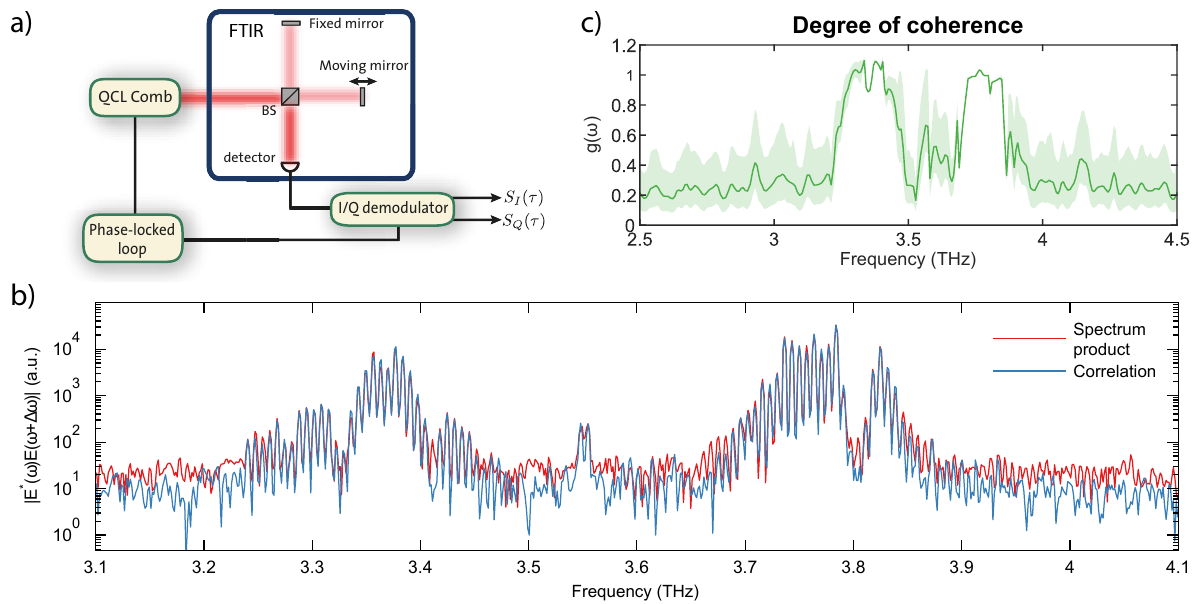
Figure 15: Shifted wave interference Fourier transform spectroscopy (SWIFTS). a Schematic representation of SWIFTS characterization sys- tem. The output of a FTIR is sent to a high-bandwidth detector. The detected signal is sent to an I/Q demodulator in order to get access to the in-phase and quadrature signals, S I ( τ , ω 0 ) and S Q ( τ , ω 0 ) ,respectively. By combining both signals, the correlation of the electric field of two adjacent modes < E * ( ω ) E ( ω ± ν rep ) > can be calculated. The intermode beatnote of the QCL has to be phase-locked to the local oscil- lator of the I/Q modulator. b SWIFTS correlation spectrum together with the spectrum product. Similar to the intermode beat spectroscopy, these results analyzed with SWIFTS also shows that most of the spectral power is in the frequency comb. c Degree of relative coherence g ± ( ω , ω ± ν rep ) obtained by SWIFTS. Results published in [70, 75]. Table 1: Comparison between intermode beat spectroscopy and SWIFTS, characterization methods developed for assessing the